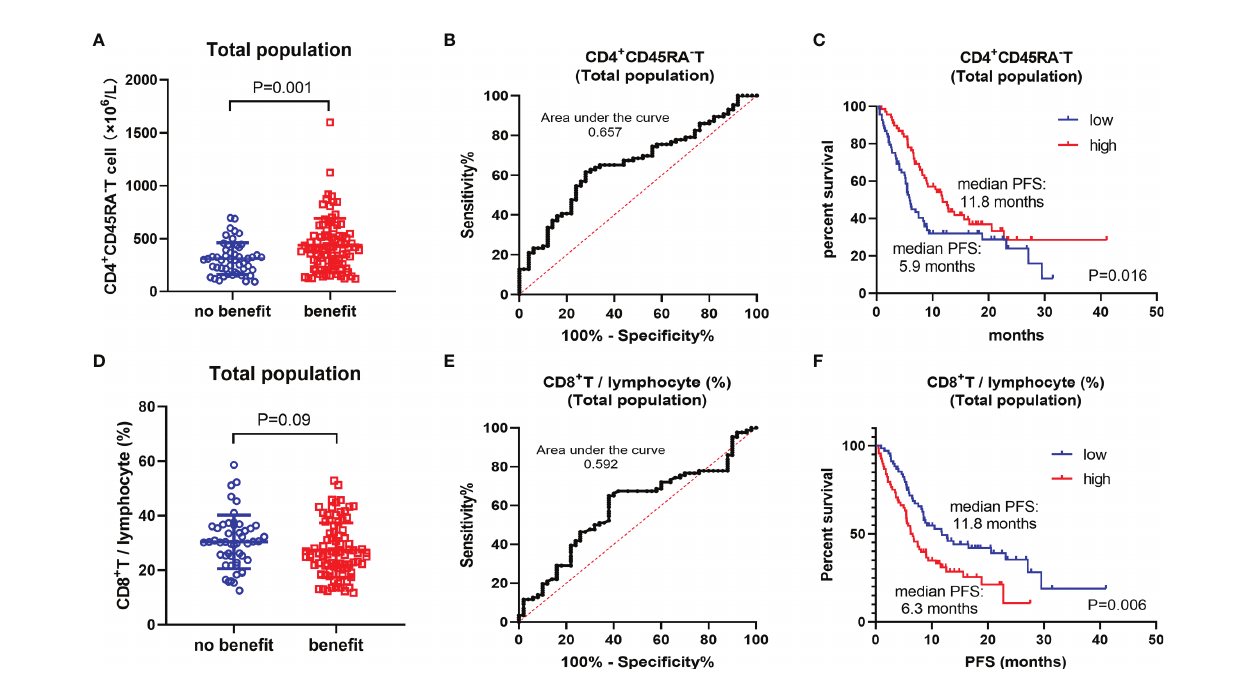
FIGURE 1 | Total population analysis. (A) Differences of CD4 + CD45RA − T cell between bene fi t group and non-bene fi t group. (B) ROC curve of CD4 + CD45RA − T cell. (C) Kaplan – Meier survival curve of different levels of CD4 + CD45RA − T cell. (D) Differences of CD8 + T/lymphocyte (%) between bene fi t group and non-bene fi t group. (E) ROC curve of CD8 + T/lymphocyte (%). (F) Kaplan – Meier survival curve of different levels of CD8 + T/lymphocyte